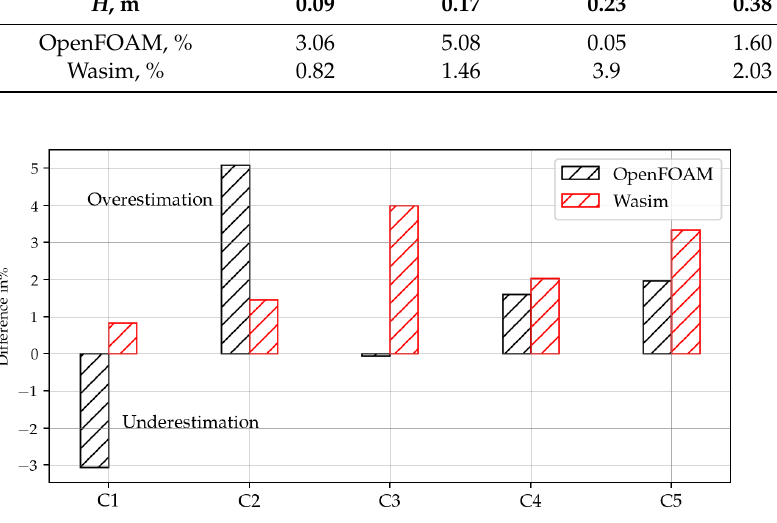
Figure 18. Difference of numerical and experimental nondimensional pitch amplitudes the 6750 TEU containership.